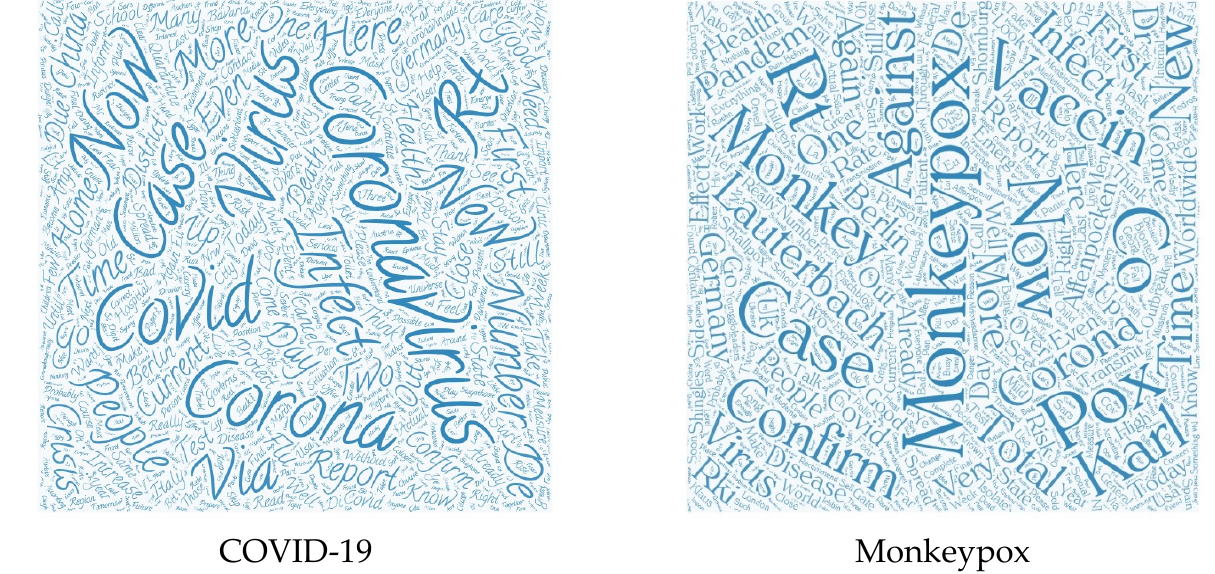
Figure 3. Word cloud analysis of COVID ‐ 19 and monkeypox.